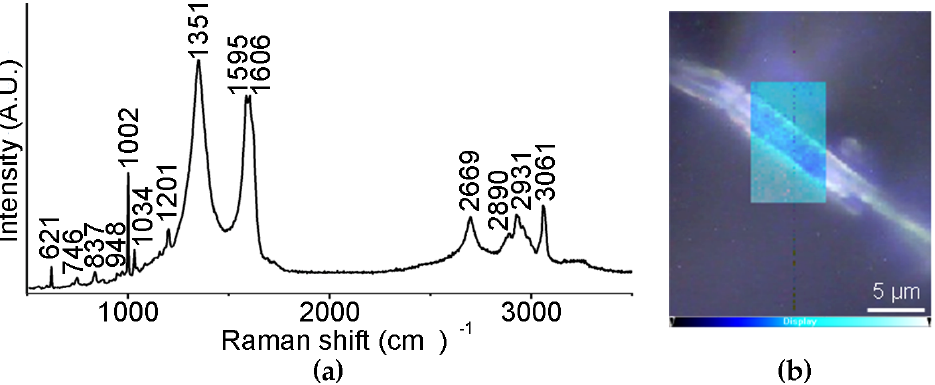
Figure 6. ( a ) Raman spectrum of the nanocomposite supramolecular hydrogel formed by Lff in the presence of oxi ‐ CNOs. ( b ) Raman mapping of a non ‐ covalent hydrogel fiber; intensity scalebar: the brighter cyan areas correspond to higher levels of oxi ‐ CNOs.